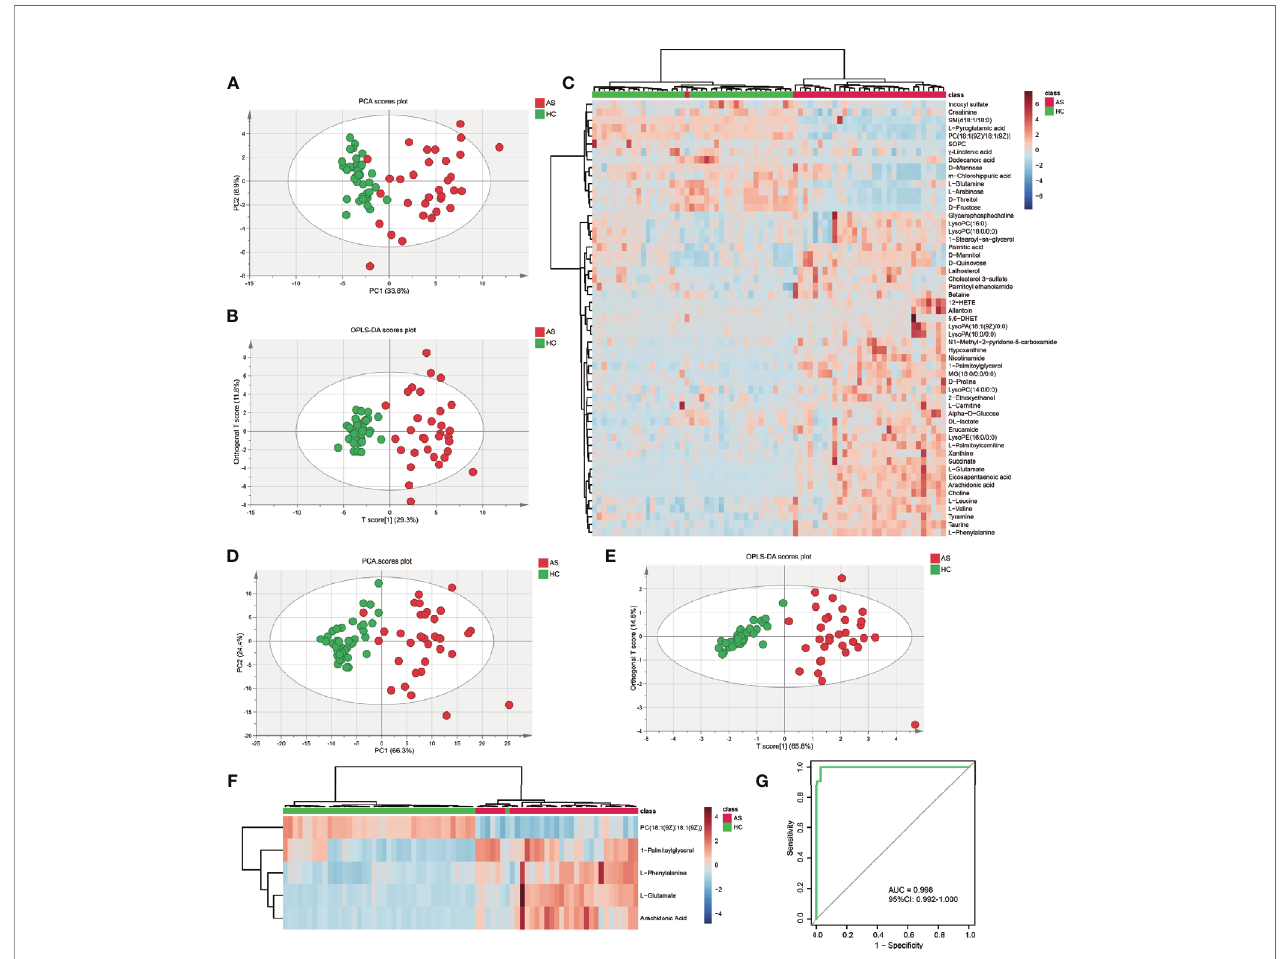
FIGURE 3 | The capacity of 55 discrepant serum metabolites and LASSO-based model in discrimination. (A) The scatter plot of principal component analysis (PCA) was based on 55 metabolites to discriminate ankylosing spondylitis patients (AS, red circles) from healthy controls (HCs, green circles). (B) Orthogonal partial least- squares discriminant analysis (OPLS-DA) scatter plot of 55 metabolites. (C) Unsupervised cluster heatmap of 55 metabolites. (D) The scatter plot of PCA was based on 5 metabolites. (E) OPLS-DA scatter plot of 5 metabolites. (F) Unsupervised cluster heatmap of fi ve metabolites. (G) Receiver operating characteristic curve (ROC) analysis of the 5 metabolites panel for